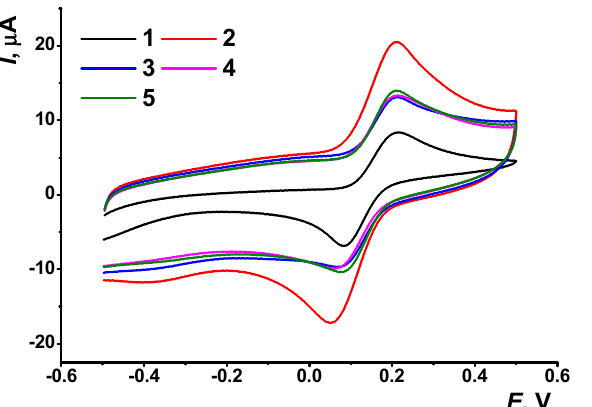
Figure 8. Cyclic voltammograms of 0.5 mM hydroquinone on GCE (1) covered with CB (2), DNA (0.4 mg/mL), with 50 µ M TC and thermally denatured DNA (0.4 mg/mL) with 50 µ M TC. Measure- ments in 0.1 M HEPES, pH = 7.0, 100 mV/s.